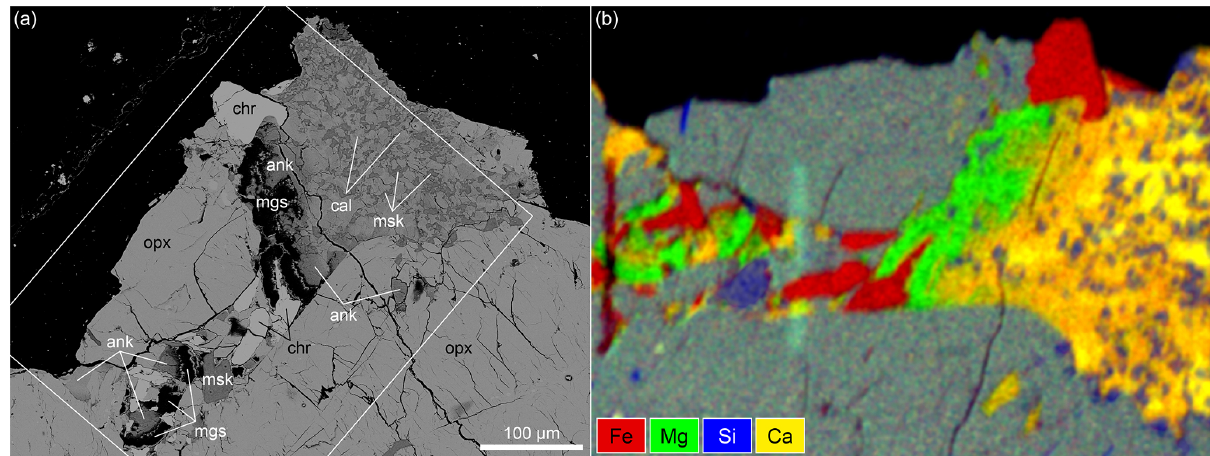
Figure 1. Backscattered electron image (a) and composite X-ray map (b) of the target carbonate patches in ALH 84001. Mineral abbrevia- tions are ank = ankerite, cal = calcite, chr = chromite, mgs = magnesite, msk = maskelynite, and opx =